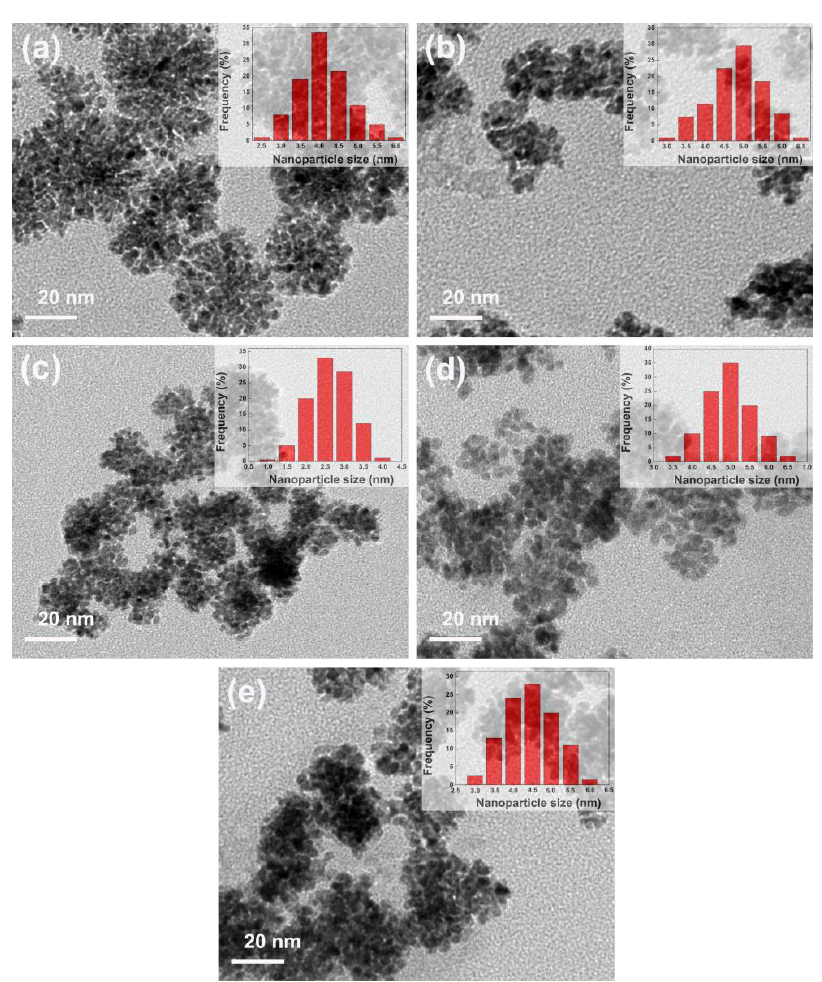
Figure 5. TEM images of Pt ML particles with ( a ) Ru, ( b ) Rh, ( c ) Pd, ( d ) Ir, and ( e ) Au cores electrodeposited on the GCE, respectively. Insets of TEM images show the corresponding particle size distribution histogram.